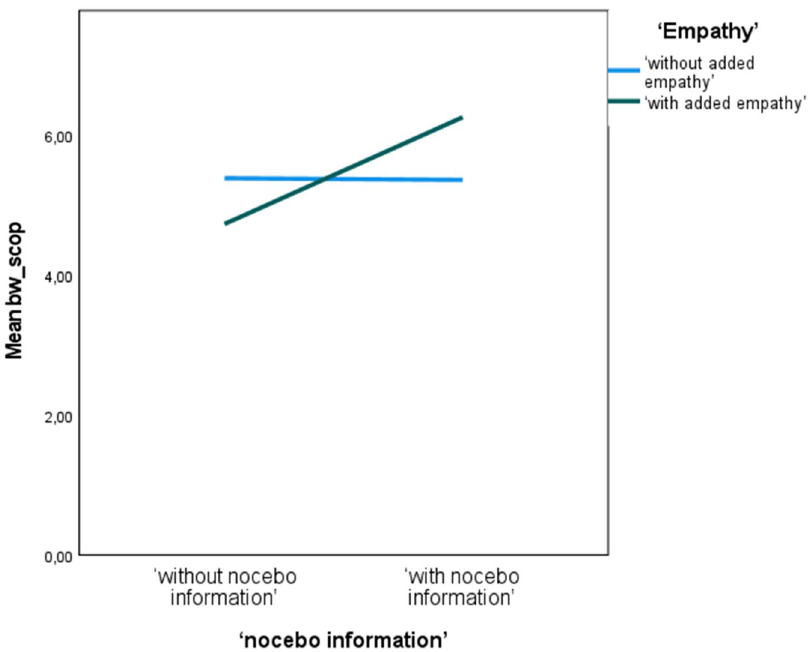
Figure 2. Interaction effect of nocebo information and empathy for coping expectations regarding specific side effects.